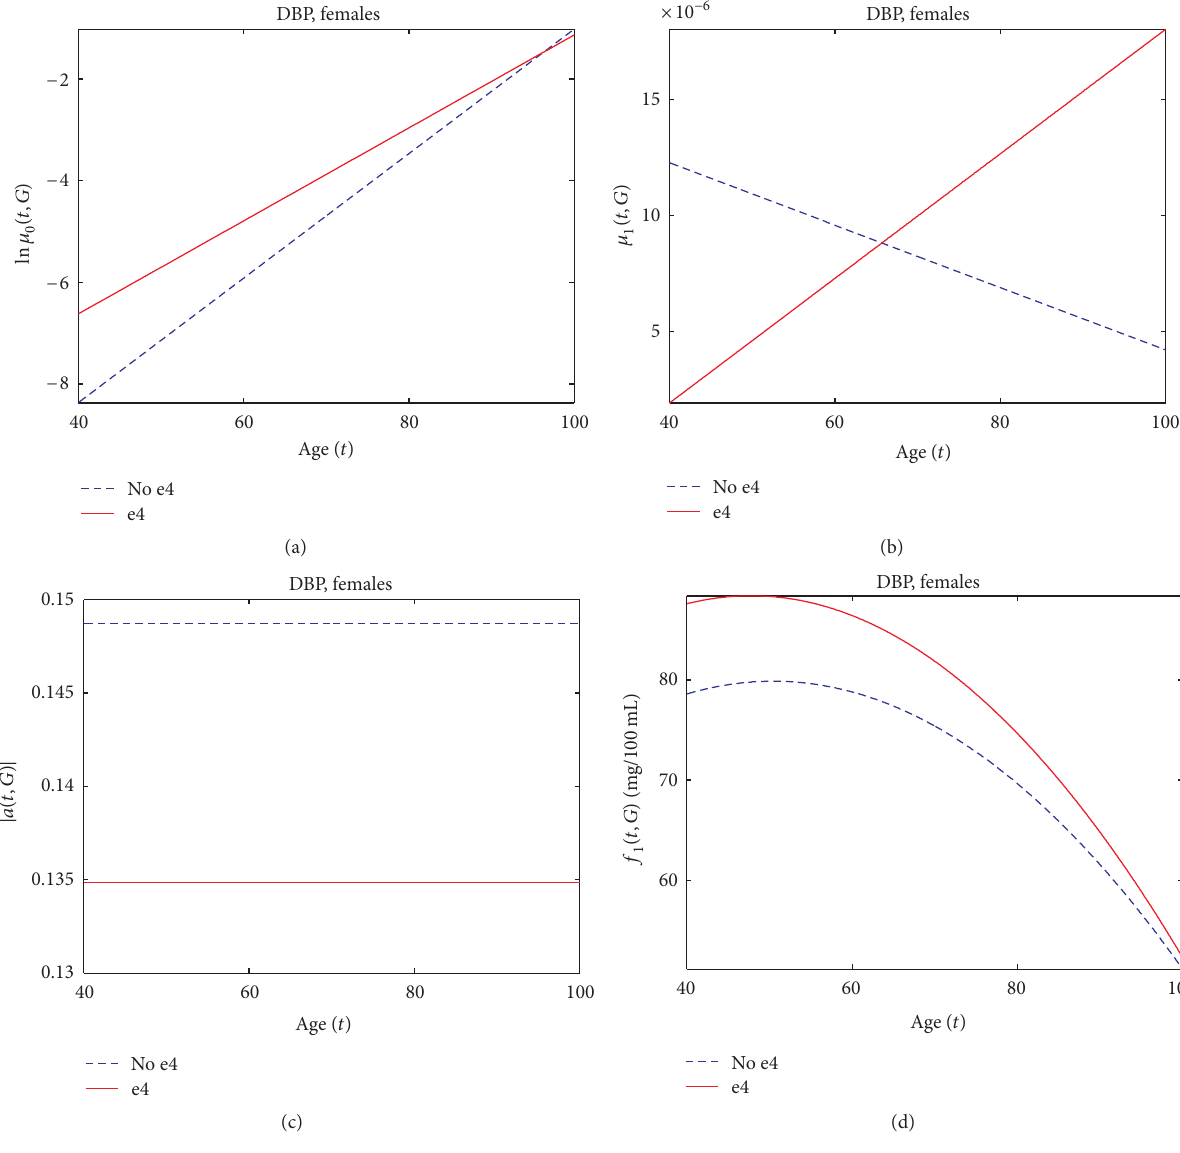
F 6: Application of the genetic stochastic process model to longitudinal measurements of diastolic blood pressure (“DBP”) and data on mortality for females in the Framingham Heart Study (original cohort). Estimates of the logarithm of the baseline hazard (a), the multiplier in the quadratic part of the hazard (b), the adaptive capacity (the absolute value of the feedback coefficient) (c), and the mean allostatic trajectory (d) for carriers (“e4”) and noncarriers (“No e4”) of the APOE e4